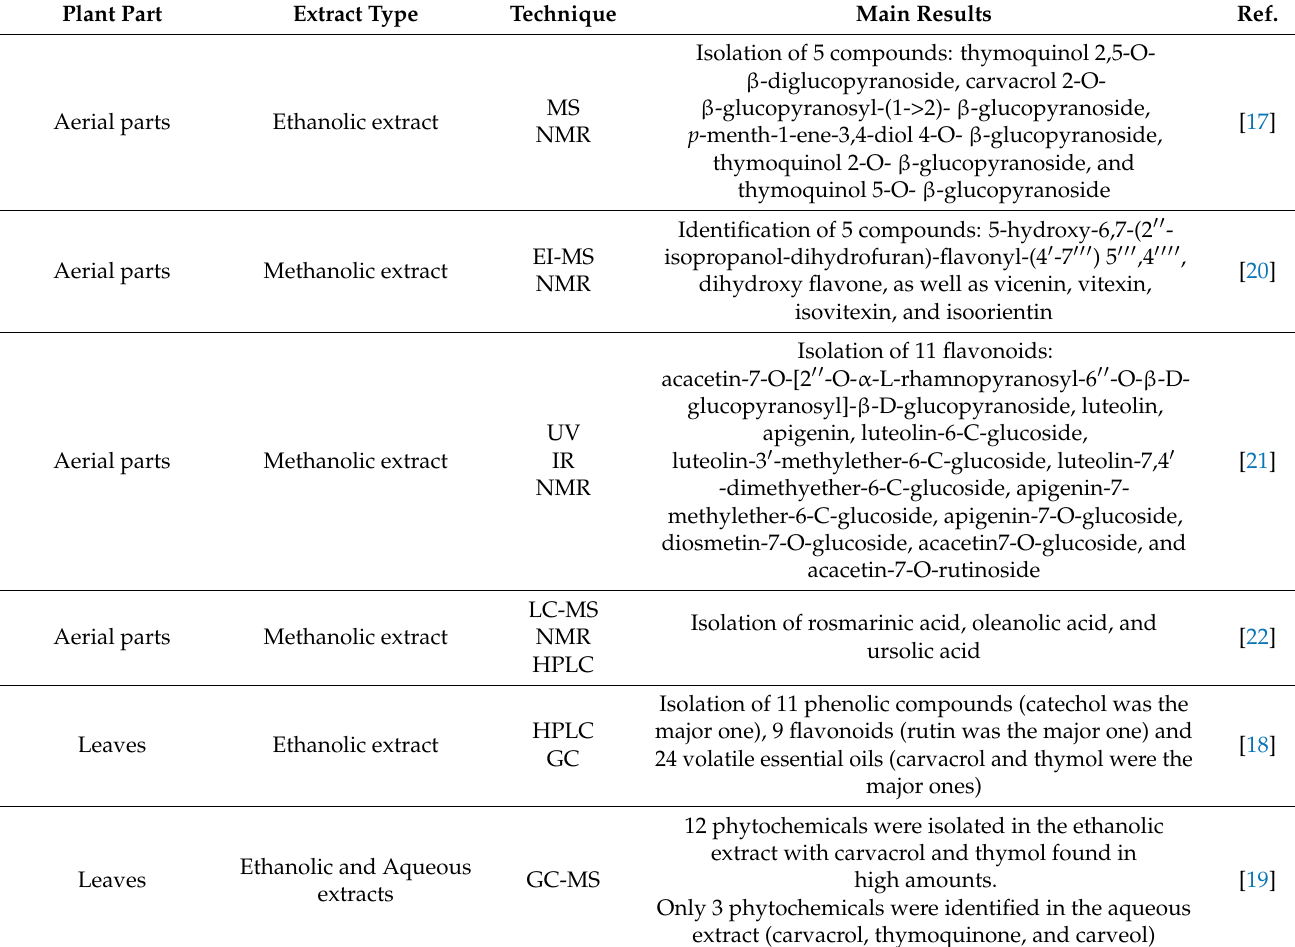
Table 1. Summary of phytochemical composition of Origanum Syriacum